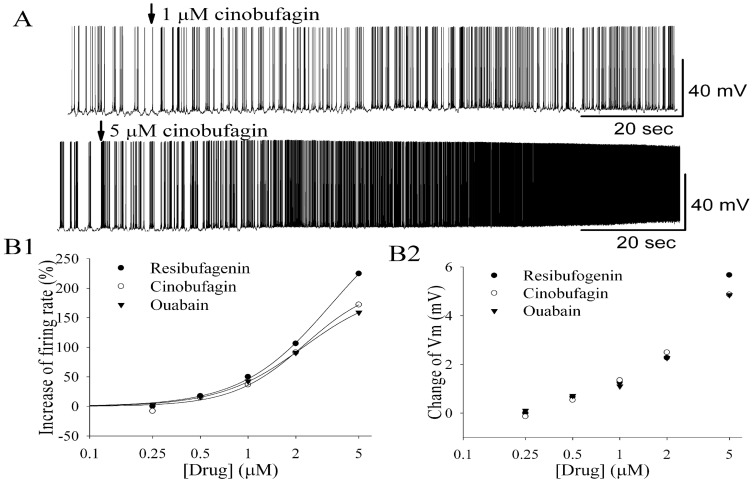
Bufadienolides and ouabain enhanced the firing activity of MCs in a concentration-dependent manner.
A Original recording from a representative MC illustrated the increase in firing rate and depolarization following application of cinobufagin at 1 µM and 5 µM, respectively. B1 Concentration-response curves for spiking of MCs evoked by various concentrations of bufadienolides and ouabain. The firing rates in the presence of bufadienolides and ouabain were normalized with respect to the control condition and were averaged (each point was the mean ± SEM of 3 to 7 cells). Error bars have been left out for clarity. The lines are fits for each set of data to the Hill equation: y  =  Axn/(K
d
n + xn), where y is the increase of spiking rate, A is the maximal increase, K
d is the apparent dissociation constant for bufadienolides, and n is the Hill coefficient. K
d and A were estimated using a Marquardt nonlinear least squares routine. B2 Relationship between concentrations of bufadienolides or ouabain and evoked depolarization of membrane potential. Error bars were left out for clarity.